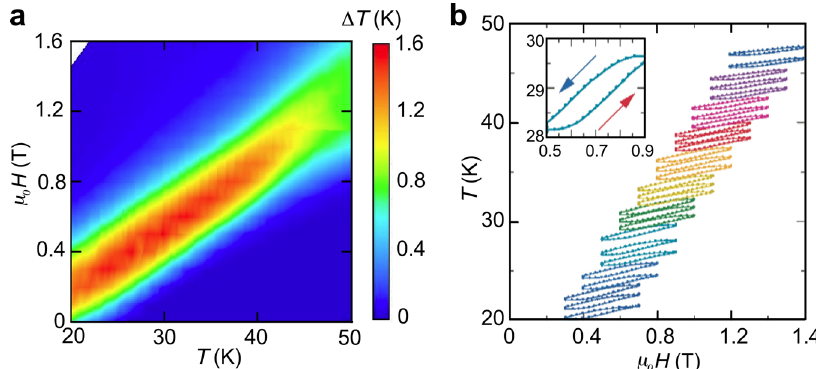
Fig. 5 Results of the direct measurement of temperature change in holmium. a Mapping of temperature change Δ T as a function of the bias magnetic fi eld μ H 0 0 and temperature. b Typical heat cycles when the magnetic most ef fi cient cycle for μ 0 H 0 = 0.5 T and T = 28.2